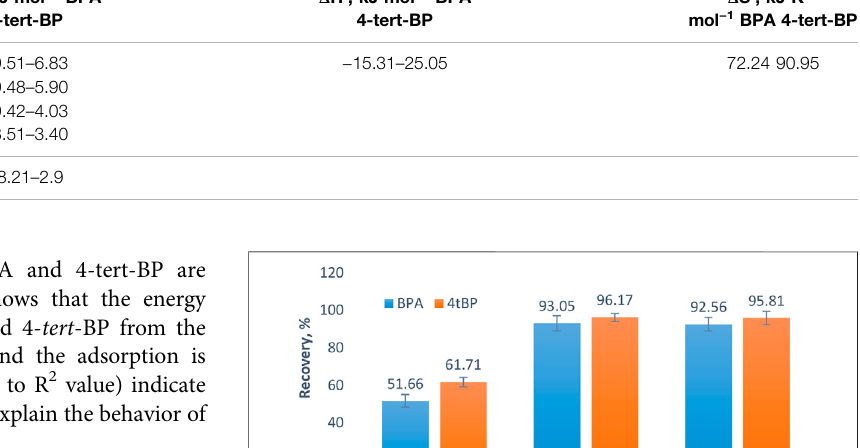
TABLE 3 | Thermodynamic parameters for the adsorption of BPA and 4- tert -BP onto MC. Temperature (K)